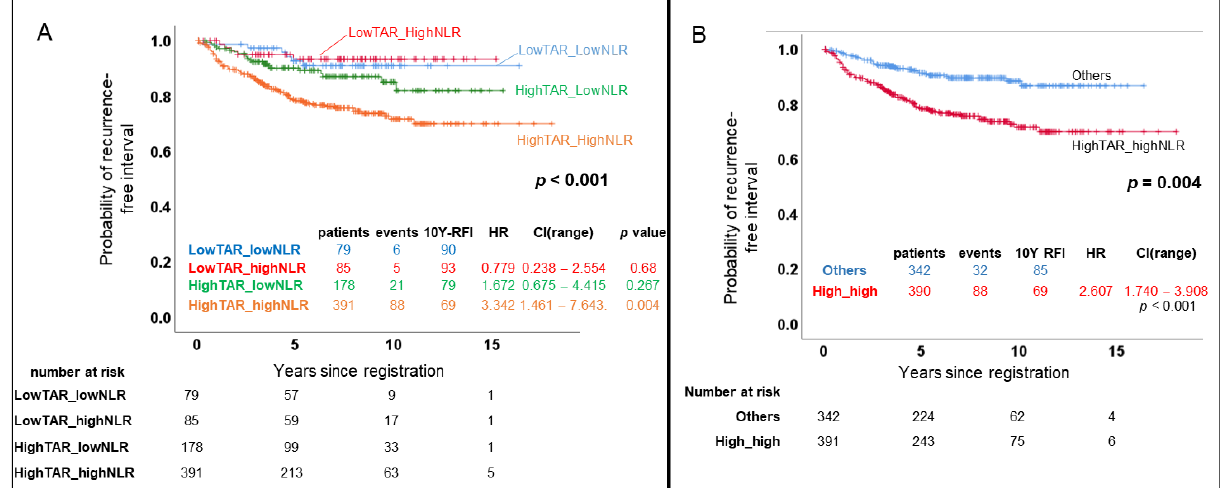
Figure 4. Recurrence-free interval (RFI) of patients categorized into four groups according to the high and low values of the tumor-to-aorta ratio (TAR) of Hounsfield units on contrast-enhanced computed tomography and serum neutrophil-to-lymphocyte ratio (NLR). ( A ) A Kaplan–Meier (KM) graph was generated and compared with a log-rank test. This showed that only patients with high TAR and high NLR showed worse prognoses than other groups; ( B ) Patients were dichotomized into two groups: those with high values of both TAR and NLR (high-high) and the other patients with only one or fewer factors higher than the cut-off value (the others). The high-high group had a significantly worse prognosis than the other groups.